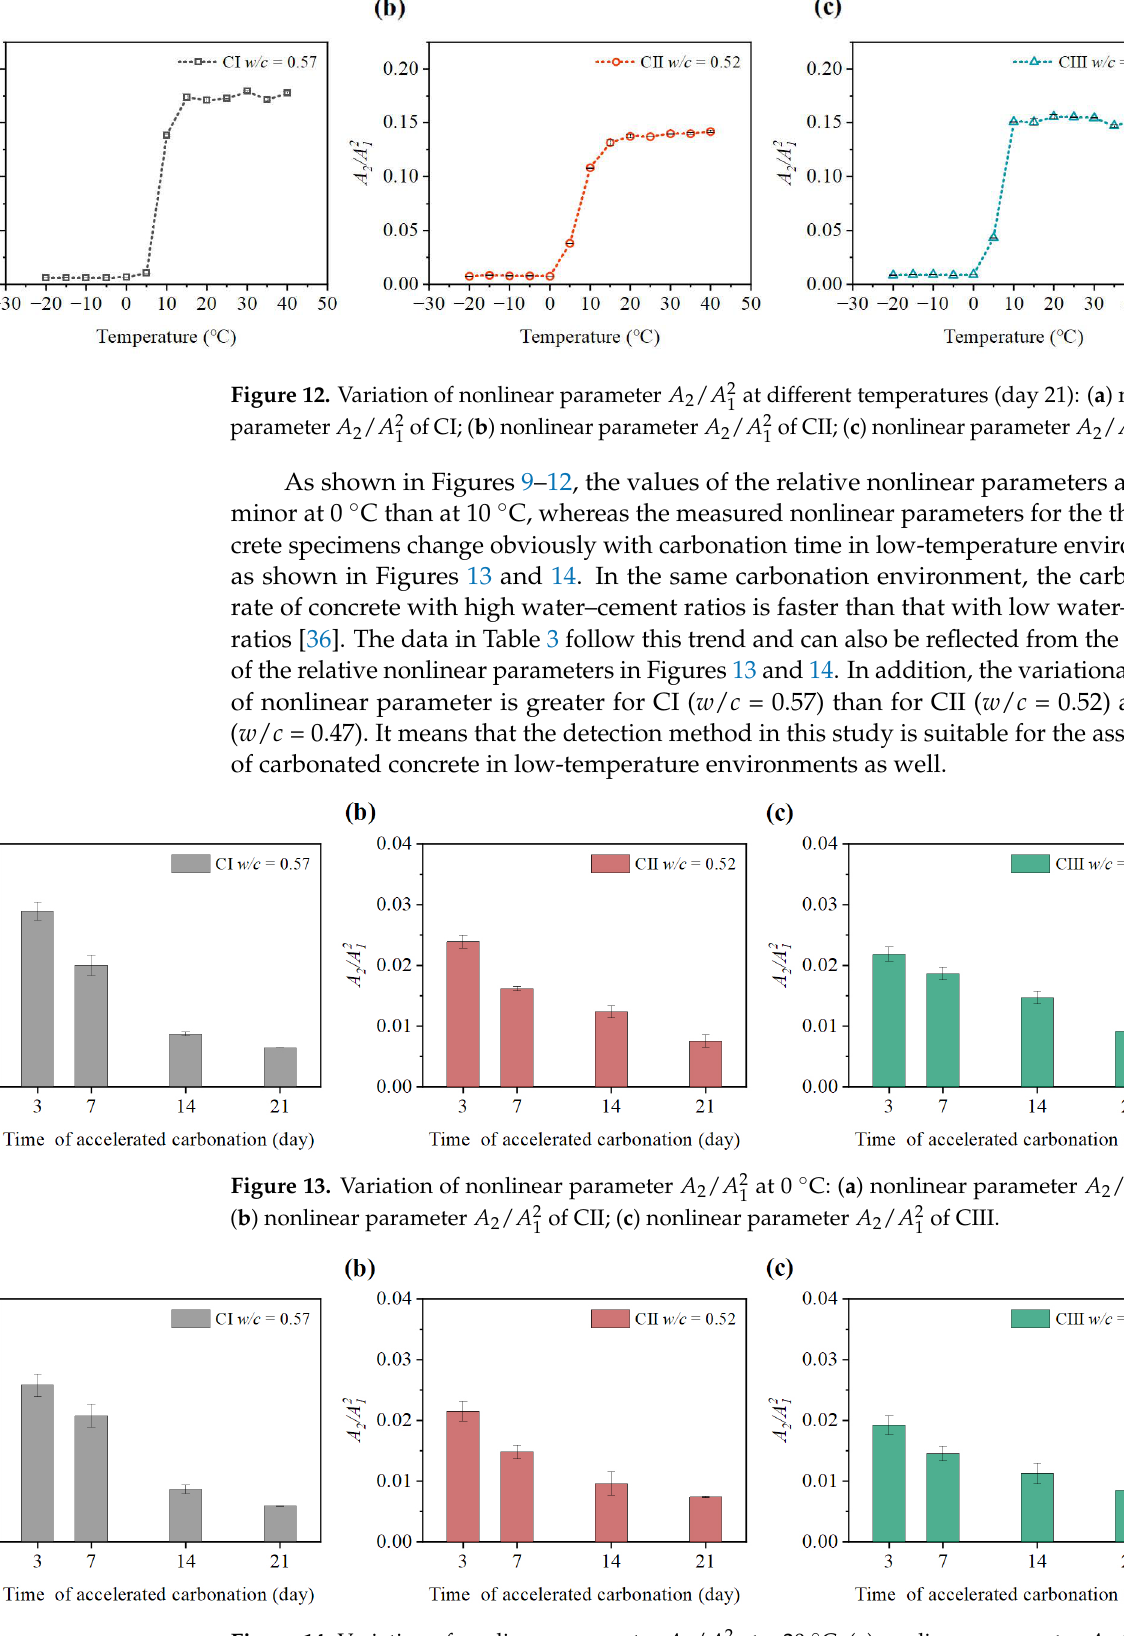
at − 20 ◦ C: ( a ) nonlinear parameter A 2 / A 2 1 of 1